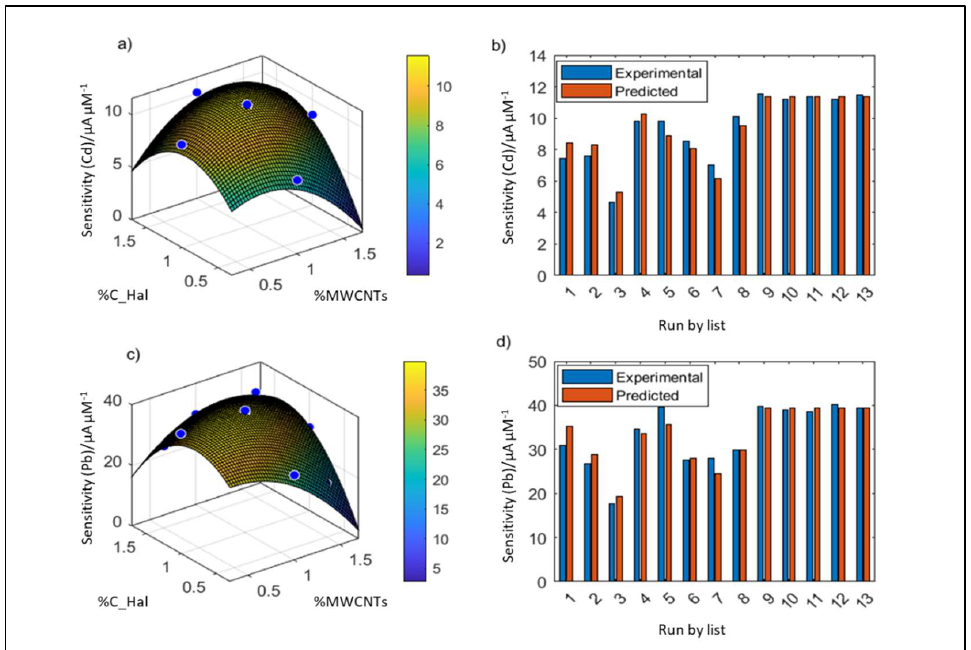
Figure 1. Response surface plots and model evaluation (predicted/experimental) for the optimization of the content of carbonized halloysite and multi-walled carbon nanotubes: ( a ) sensitivity of the Cd determination method; ( b ) comparison of the experimental and model-predicted sensitivity (Cd); ( c ) sensitivity of the Pb determination method; ( d ) comparison of the experimental and model- predicted sensitivity (Pb).